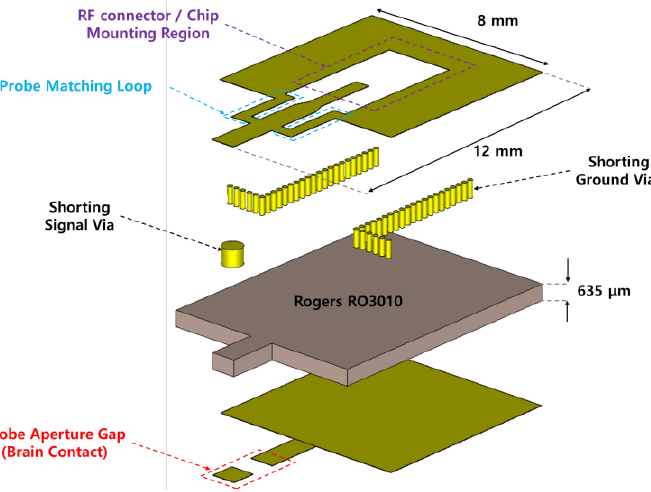
Figure 5. Exploded view of the probe with an RF connector or chip-mounted region and an aperture gap.